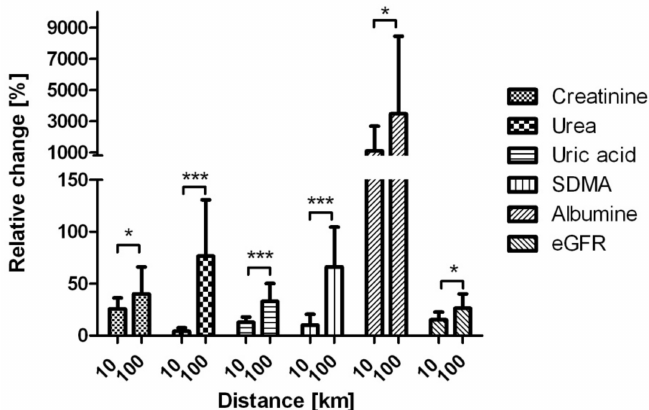
Figure 3. Relative changes [%] in the levels of measured markers between 10-km and 100-km run. Data were presented as mean and standard deviation. Only statistically significant di ff erences were presented: * p < 0.05, *** p < 0.001. Abbreviations: eGFR—estimated glomerular filtration rate, SDMA—symmetric